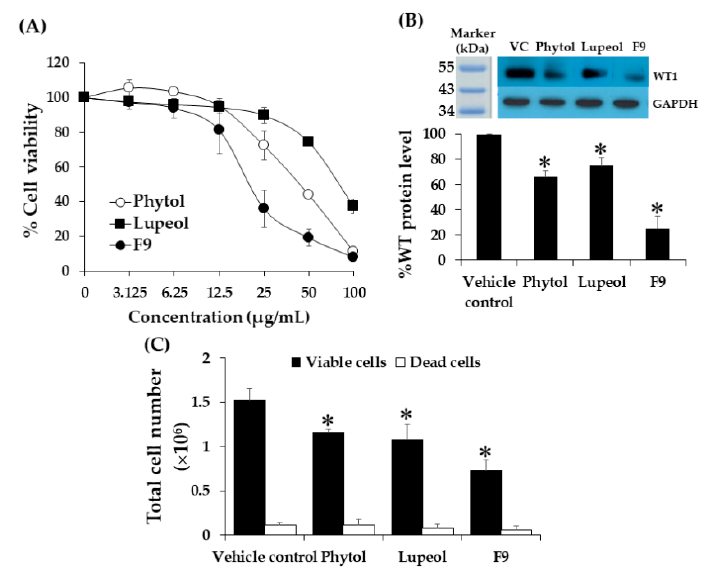
Figure 7. Effects of F9 on phosphor-kinase protein expressions in K562 cells after treating with 23.3 µg/mL for 48 h using a human phospho-kinase array kit. Asterisk (*) demonstrates statistically significant difference between the values of the vehicle control and the sample ( p < 0.05).